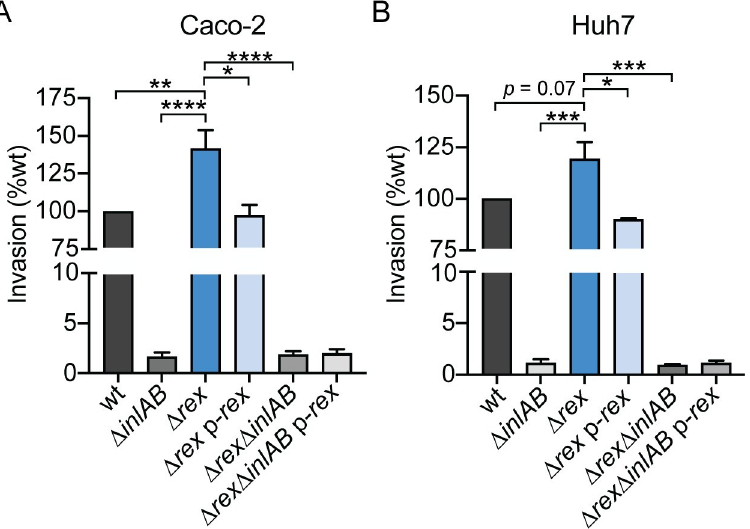
Fig 3. Alleviation of Rex repression promotes bacterial invasion of Caco-2 epithelial cells and Huh7 hepatocytes. The ability of L . monocytogenes strains to invade Caco-2 epithelial cells (A) and Huh7 hepatocytes (B) was evaluated. Bacterial invasion was measured 2 hours post-infection and 1 hour after adding gentamicin to kill extracellular bacteria. Invasion was normalized to the initial inocula and is reported as a percentage of wt. In panel A, data are the means and SEMs of 5 independent experiments performed in duplicate. In panel B, data are the means and SEMs of 3 independent experiments performed in duplicate. p values were calculated using a heteroscedastic Student’s t test. � p < 0.05; �� p < 0.01; ��� p < 0.001. No statistical significance was found between strains lacking inlAB .